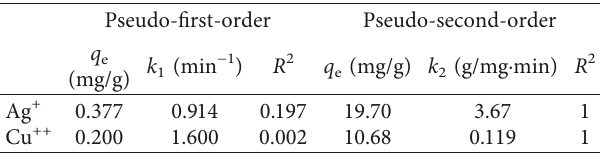
Figure 2: Effect of contact time on Ag + and Cu ++ adsorption onto Saudi clay, at metal concentration � 200mg/L, temperature � 25 ° C, and clay mass � 10g/L. Table 1: Adsorption rate constants of Ag + and Cu ++ adsorption onto clay derived from the pseudo-first-order and pseudo-second- order kinetic